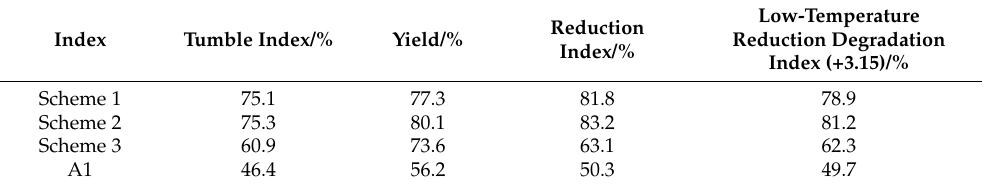
Table 8. Quality index of sinter (%).